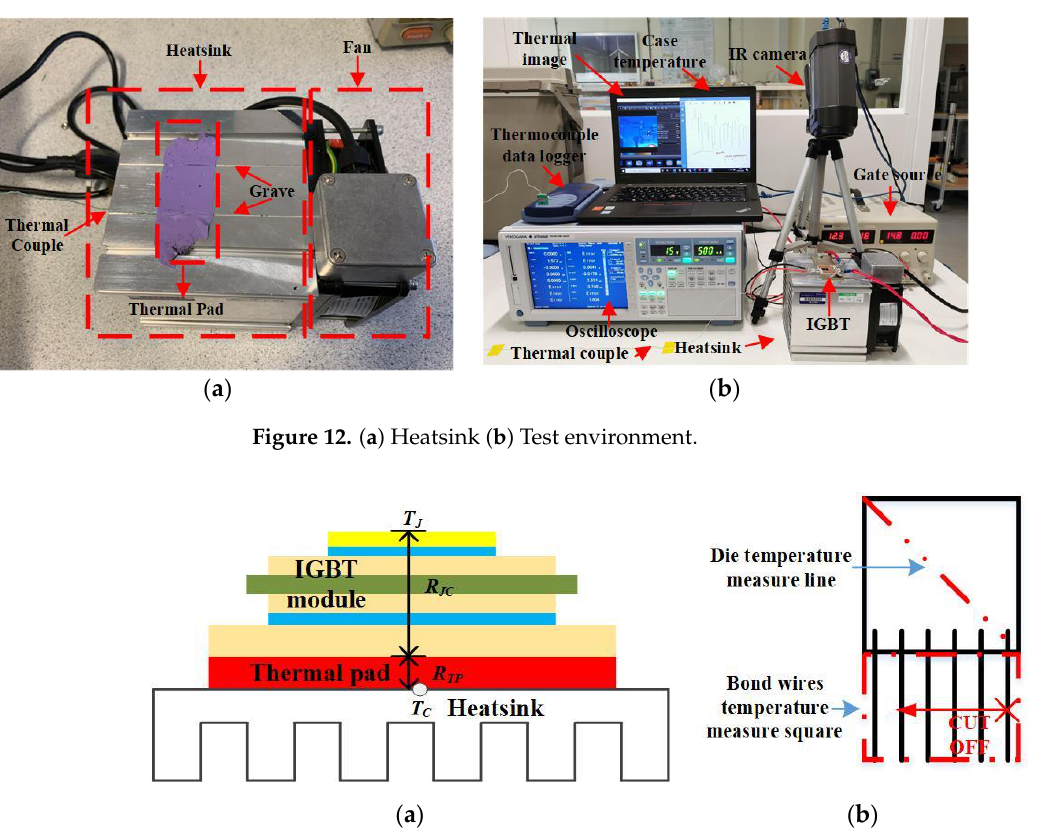
Figure 11. ( a ) Open package IGBT module, black-painted ( b ) Main electrical circuit.